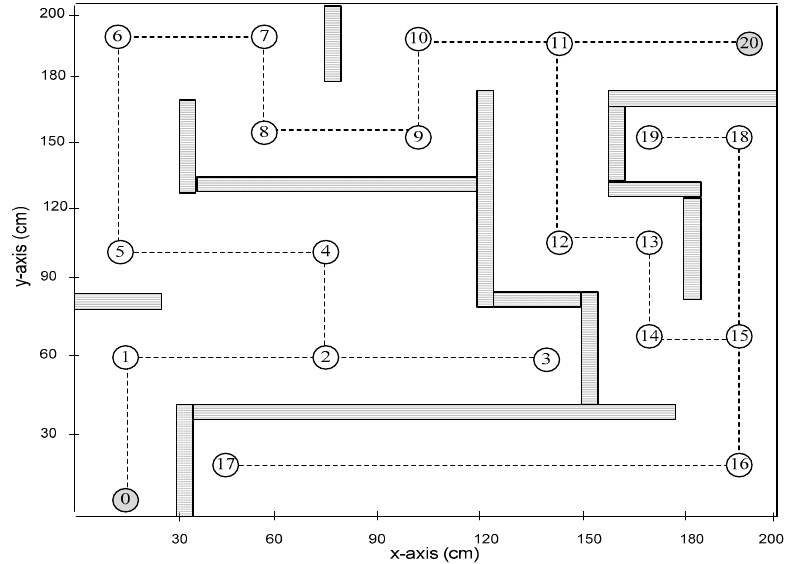
Figure 3. The constructed N-ary tree after performing the navigation task.